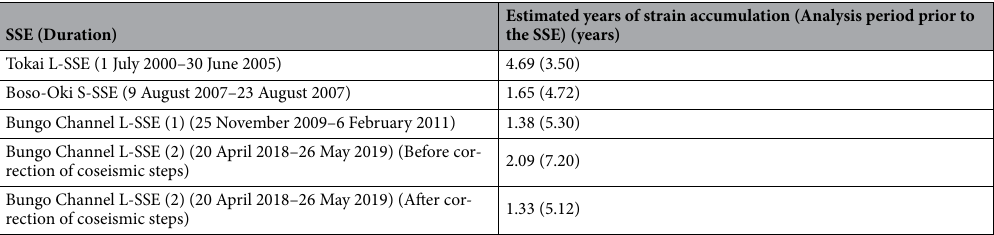
Table 1. Years of strain accumulation at each SSE. The values in parentheses in the right column represent the analysis period prior to the SSEs, whereas the values without parentheses in the right column denote the accumulation years calculated by the method described in the section of